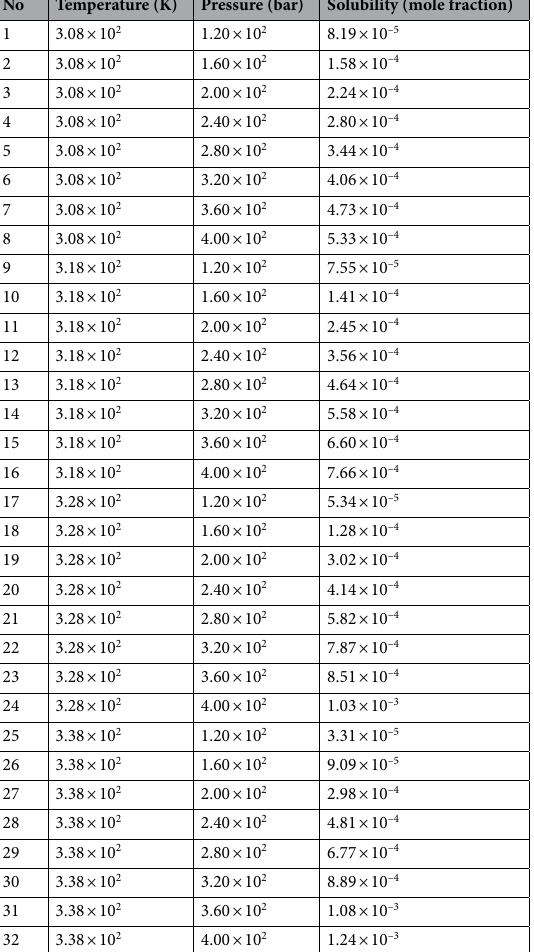
Table 1. The whole dataset: 32 data vectors, where each vector has two input parameters (pressure and temperature) and one output